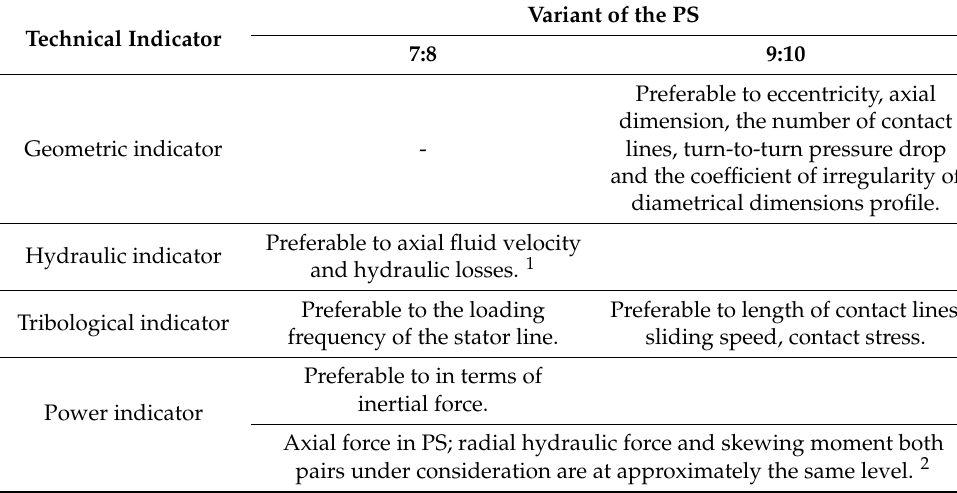
Table 5. Estimative comparative analysis of the technical indicators of